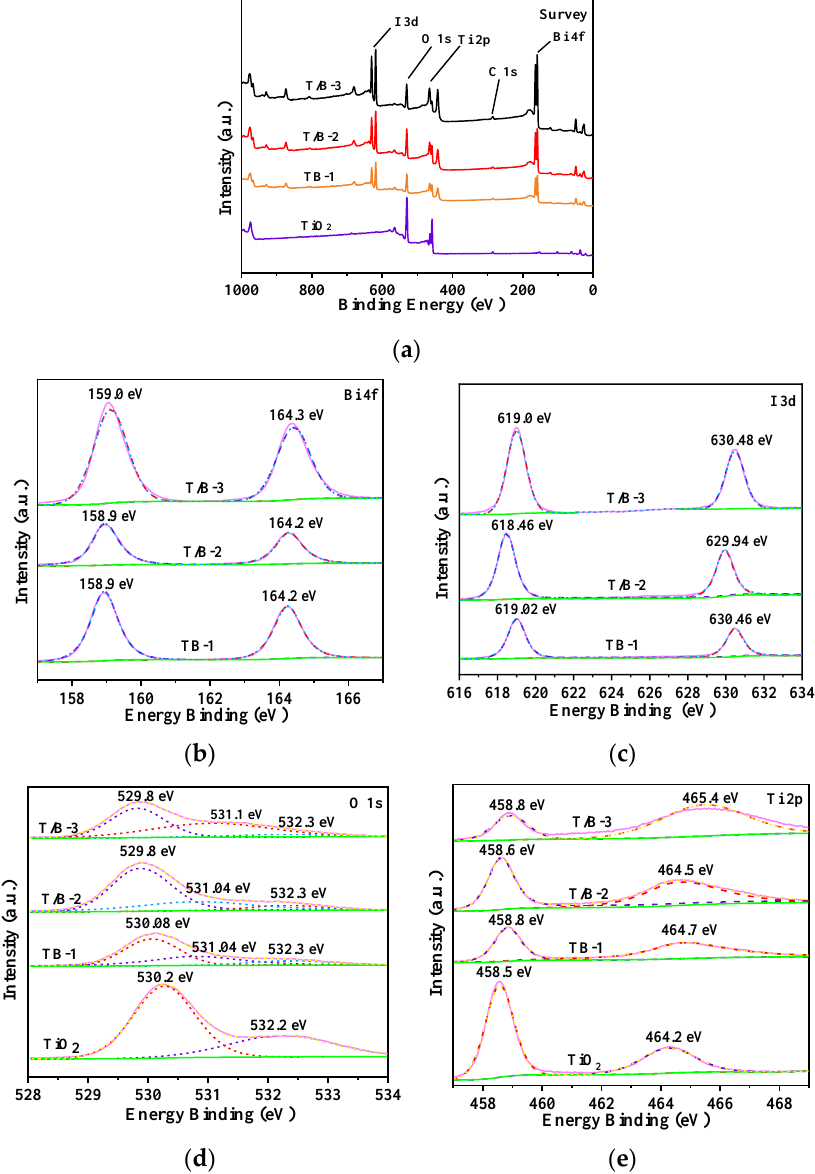
Figure 7. XPS spectra of TiO 2 , T/B-1, T/B-2 and T/B-3 composite fibers, ( a ) survey spectra, ( b ) Bi 4f spectra, ( c ) I 3d spectra, ( d ) O 1s spectra, and ( e ) Ti 2p spectra.